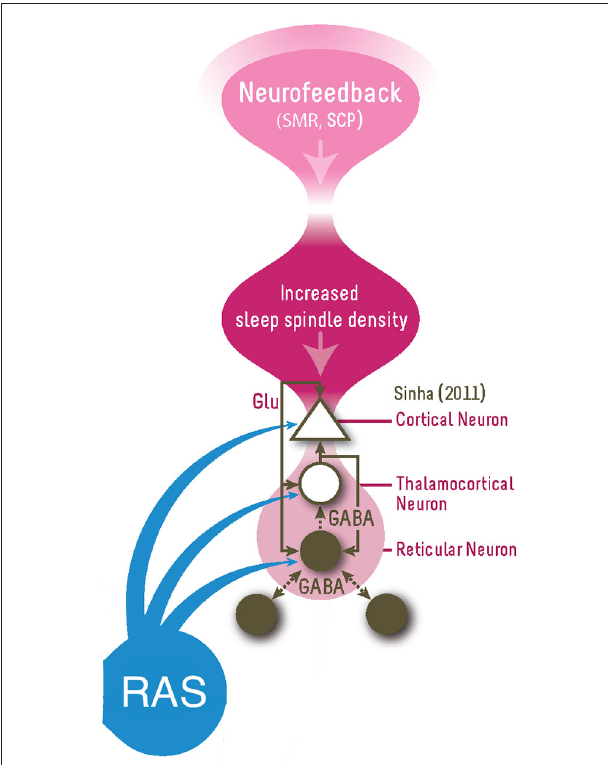
FIGURE 1 | This figure summarizes the proposed model for how neurofeedback (right top) impact on the vigilance system (responsible for sleep-wake regulation) . SMR Neurofeedback is thought to train the Reticular-Thalamocortical-Cortical network by increasing the synaptic strengths within this network via the three-way glutamatergic (Glu) connections, resulting in long-term potentiation (LTP) which increases synaptic sensitivity and the probability of future activation in this network, namely by increased sleep spindle density during sleep (Sterman and Egner, 2006). This increased sleep spindle density results in decreased sleep latency and increased total sleep time, resulting in vigilance stabilization (or improved sleep homeostatis). The RAS (Reticular Activating System) also has an influence on this circuitry (Figure adapted from Sinha